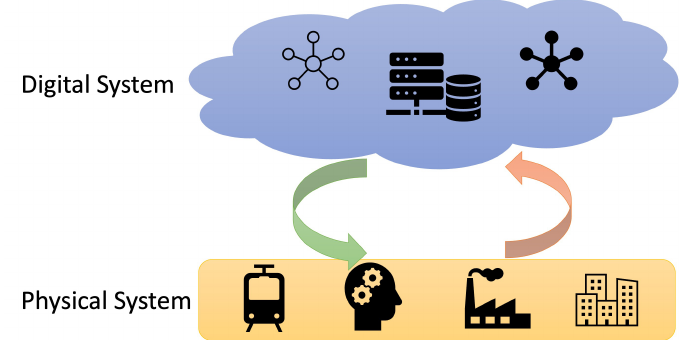
Figure 1. DT Architecture.